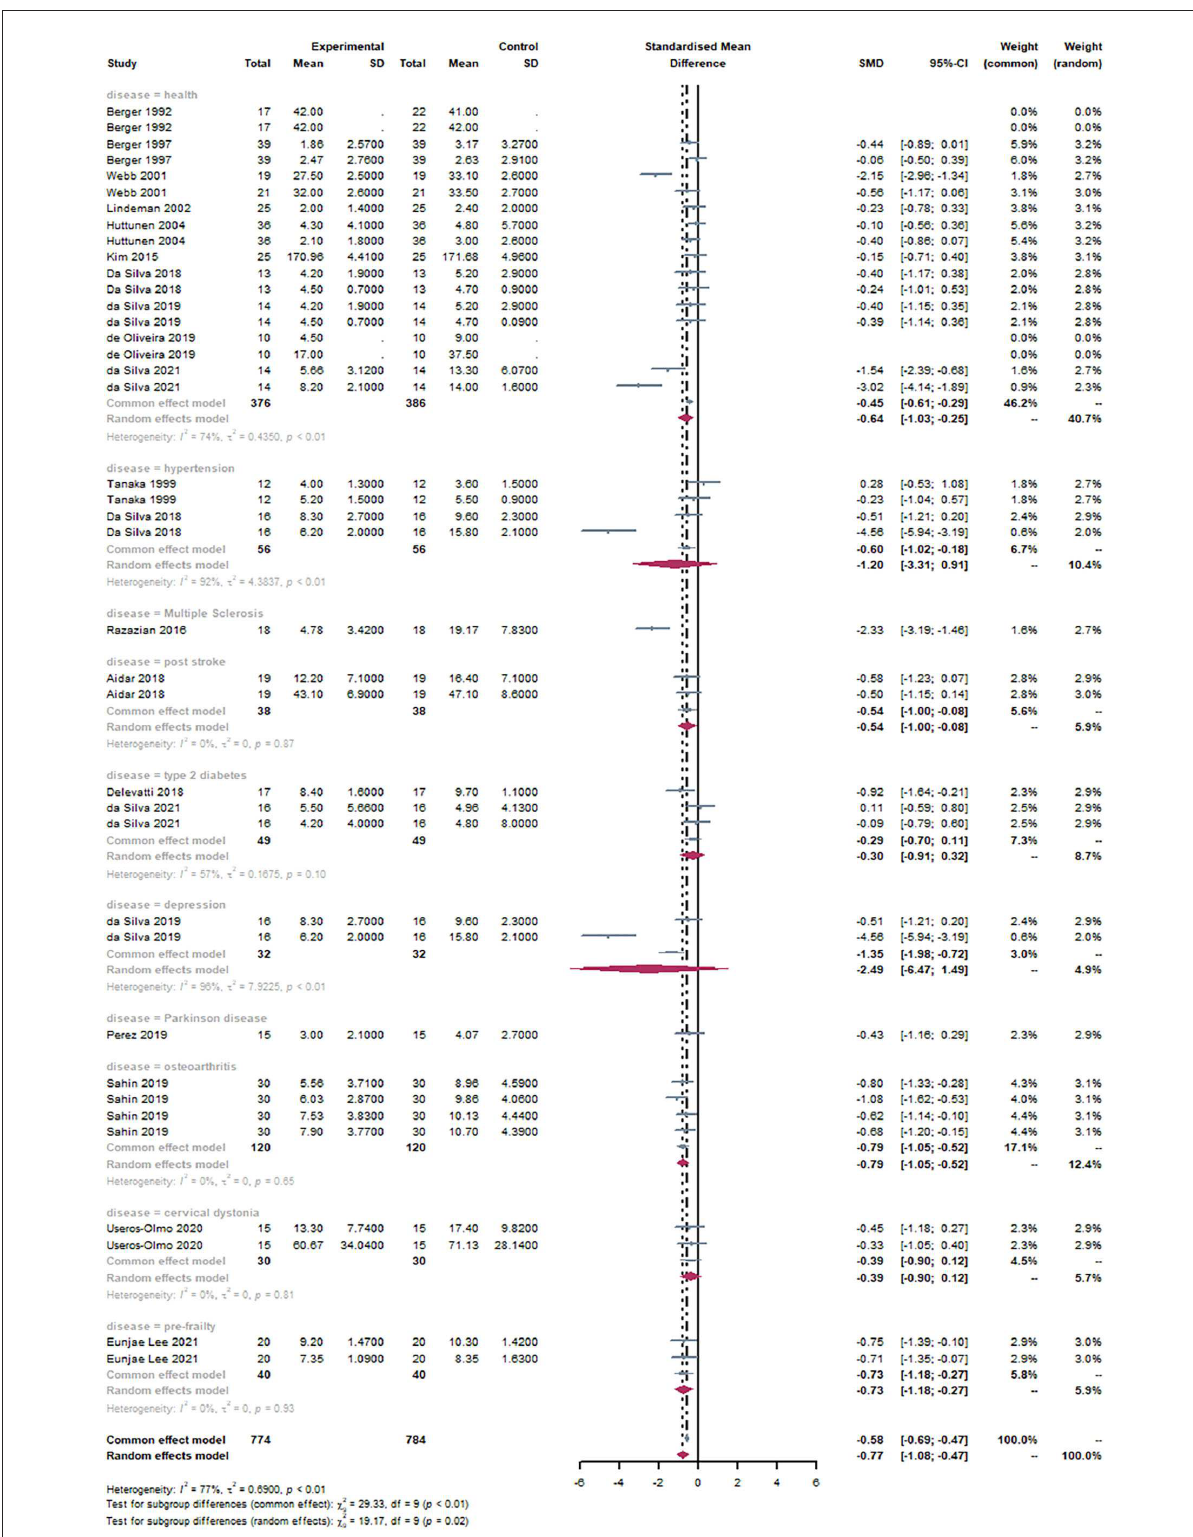
FIGURE6 Forest plot of disease. By subgroup analysis of the disease, the Health group [SMD = − 0.64, 95% CI ( − 1.03, − 0.25), I 2 = 74%, P < 0.01], Hypertension group [SMD = − 1.20, 95% CI ( − 3.31, 0.91), I 2 = 92%, P < 0.01], and Depression group [SMD = − 2.49, 95% CI ( − 6.47, 1.49), I 2 = 96%, P < 0.01] were statistically